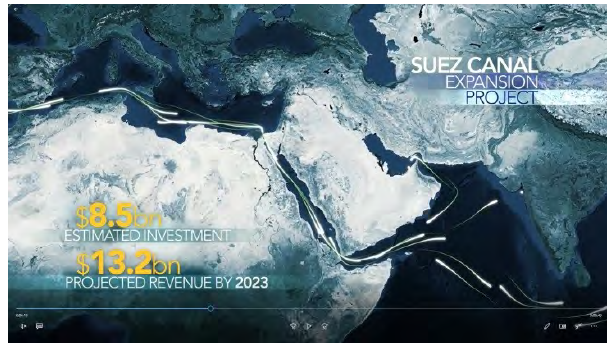
Figure 19. improving exports road through Suez canal Expansion (New Egypt Old Friends, 2016)